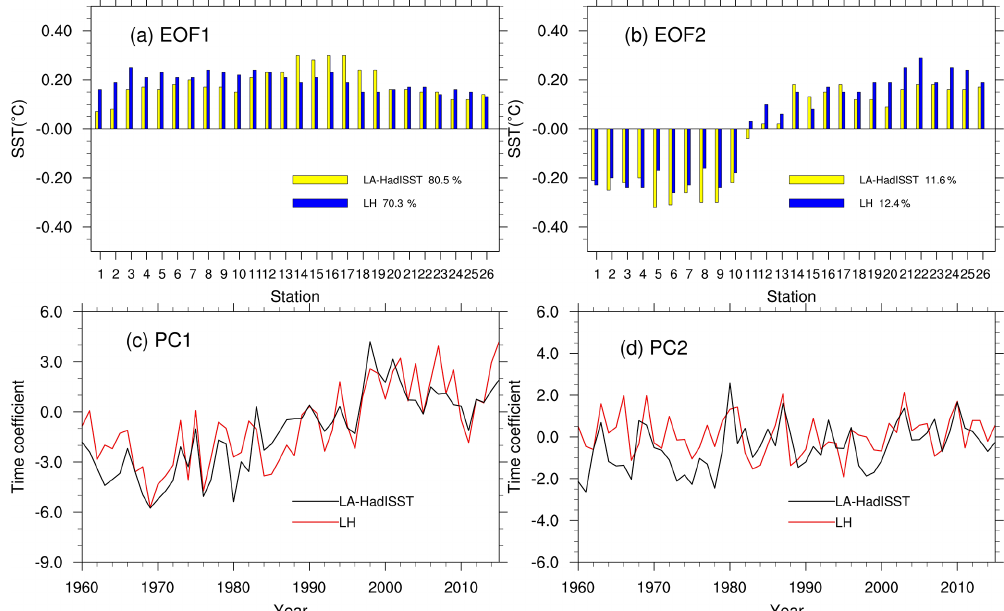
Figure 3. Comparison of the EOF1 and EOF2 derived from the LH dataset of local SST at 26 sites (blue bars; red lines) and derived from the localized analysis data LA-HadISST (yellow bars; black lines). (a, b) EOF spatial patterns, (c, d) principal components (time